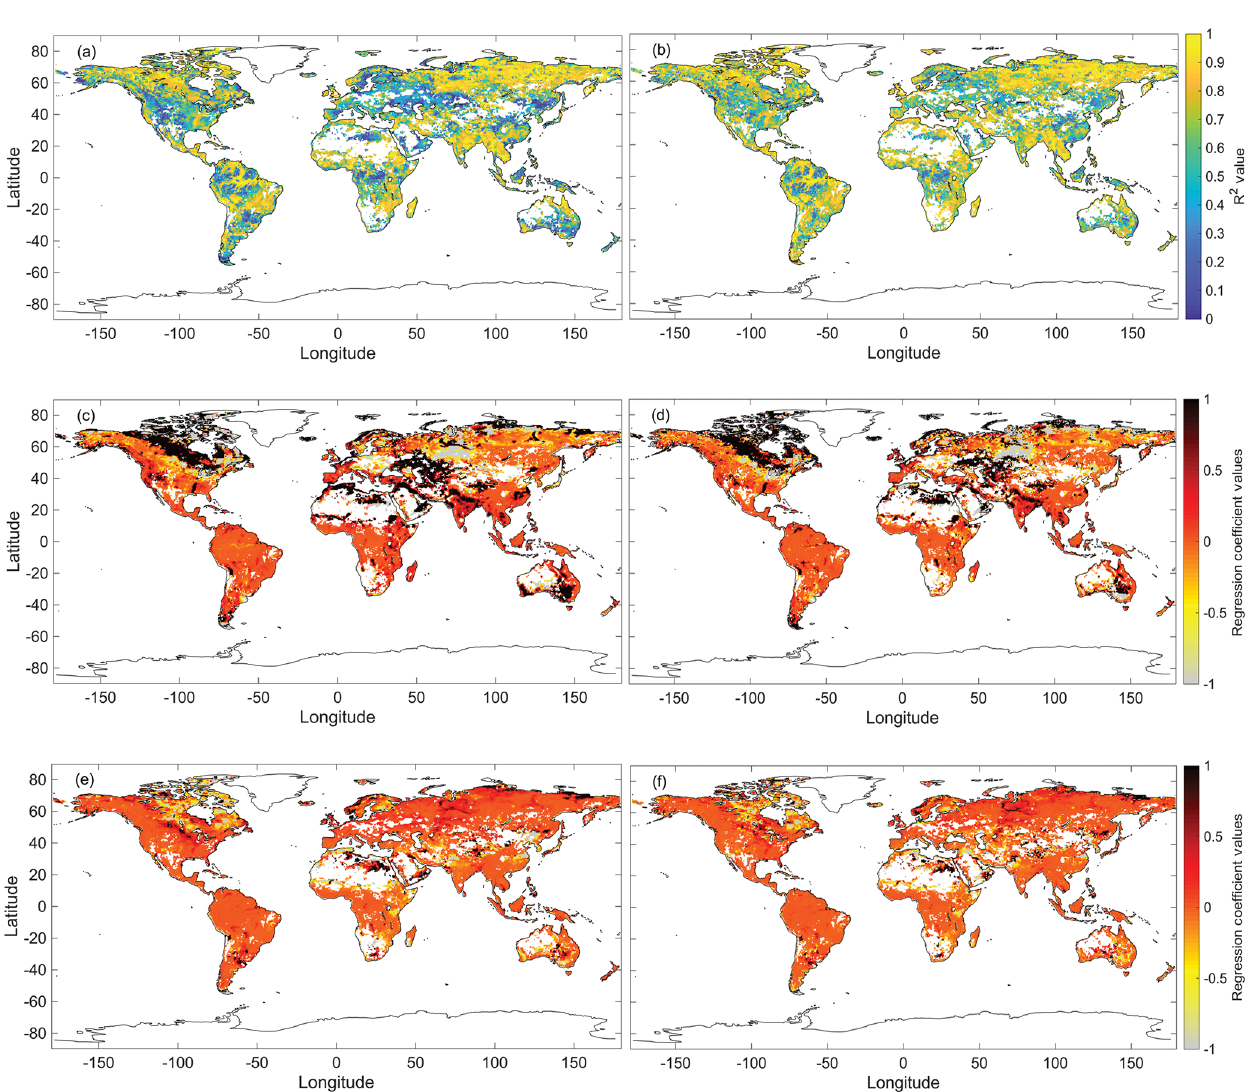
Figure 11. (a) Multi-linear regression correlations without a time lag correction. (b) Multi-linear regression correlations with a time lag correction of 0 to 5 months. (c) GPCP regression coefficients for the model in Fig. 11a. (d) GPCP regression coefficients for the model in Fig. 11b. (e) GRACE regression coefficients for the model in Fig. 11a. (f) GRACE regression coefficients for the model in Fig.